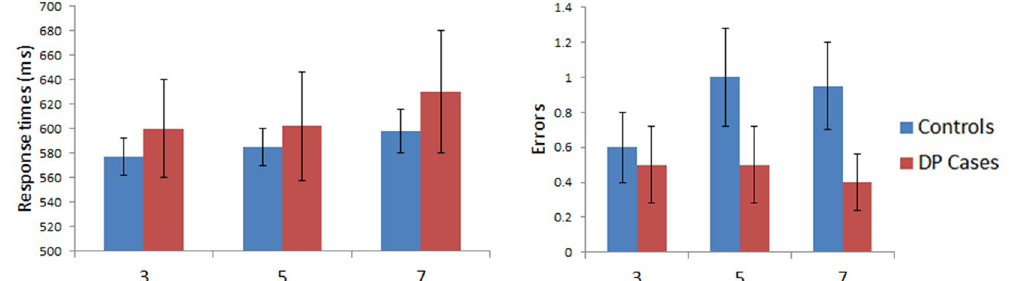
Figure 3. Results for Reading Aloud: Length (word confusability not controlled). Data are shown in left panel (response time) and right panel (number of errors) for control and DP groups. Error bars display ± SEM. The three conditions are words comprised of 3-, 5-, and